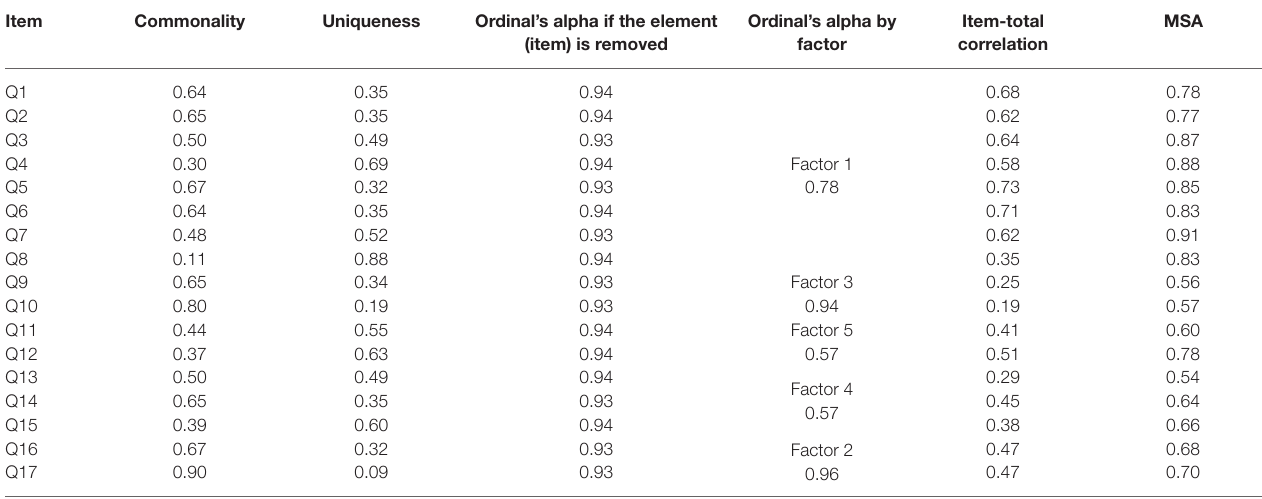
TABLE 3 | Commonality, uniqueness, ordinal’s alpha if the element (item) is removed, ordinal’s alpha by factor, item-total correlation, and measure of sample adequacy (MSA) for the questionnaire. Item Commonality